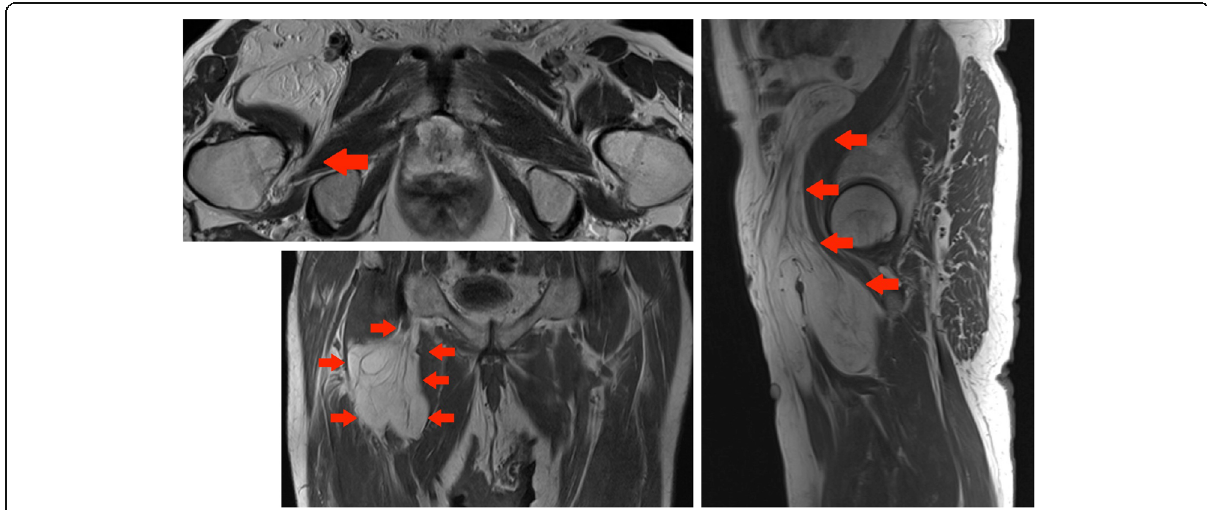
Fig. 14 Top left panel: Axial T2-weighted MR image of the pelvis: a large lipomatous tumour arising from the right iliopsoas compartment is seen to extend to the iliopsoas insertion onto the lesser trochanter (red arrow). Bottom left panel: Coronal T1-weighted MR image of the pelvis: large lipomatous mass in the right iliopsoas compartment (red arrows). Internal septations and ‘ haziness ’ of the fat suggest a more aggressive lesion.